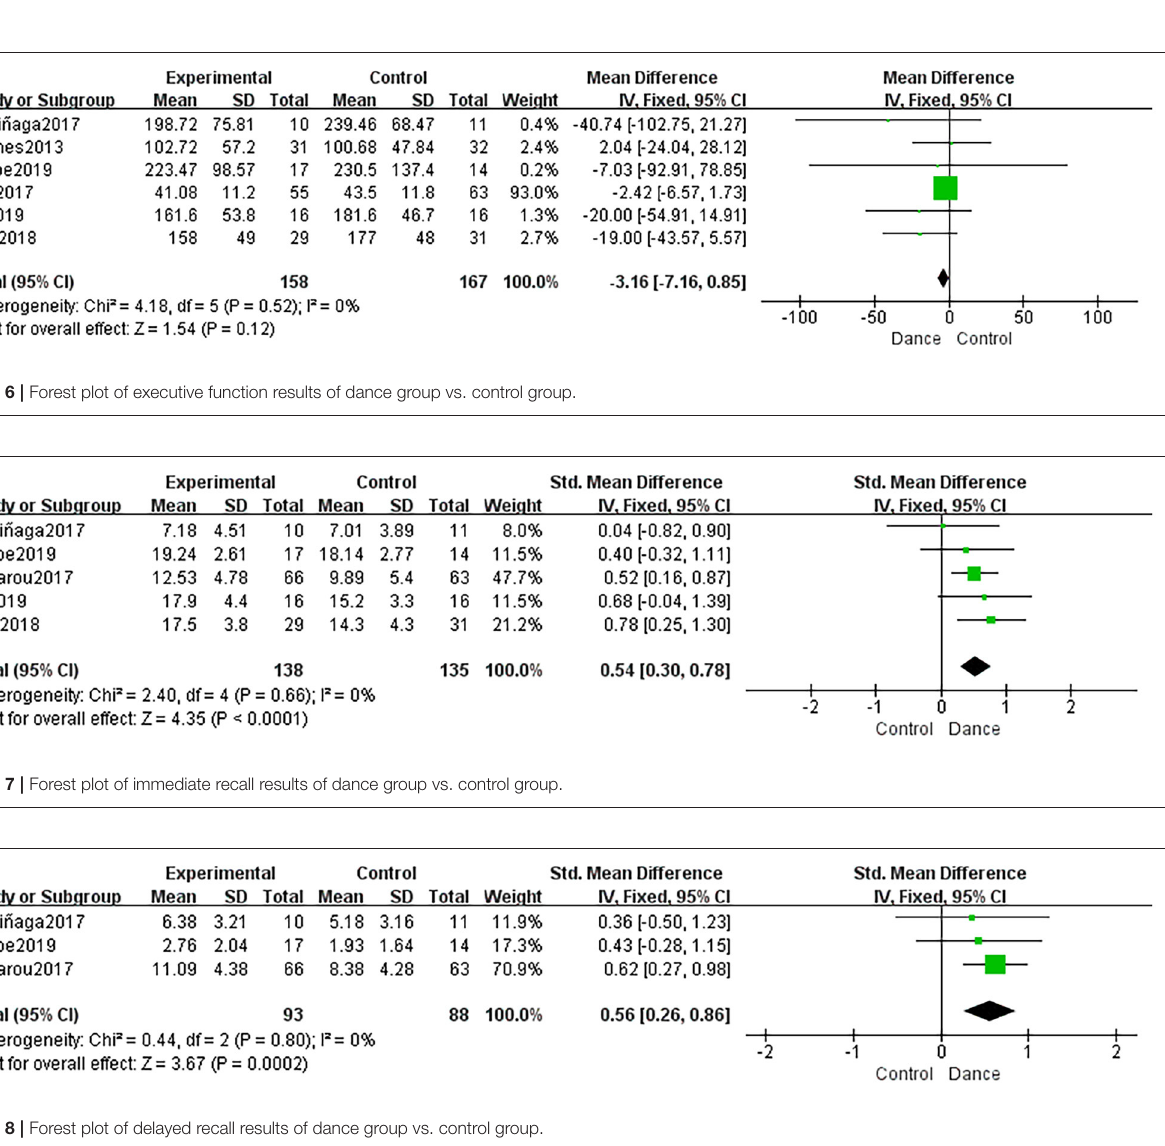
FIGURE 8 | Forest plot of delayed recall results of dance group vs. control group.